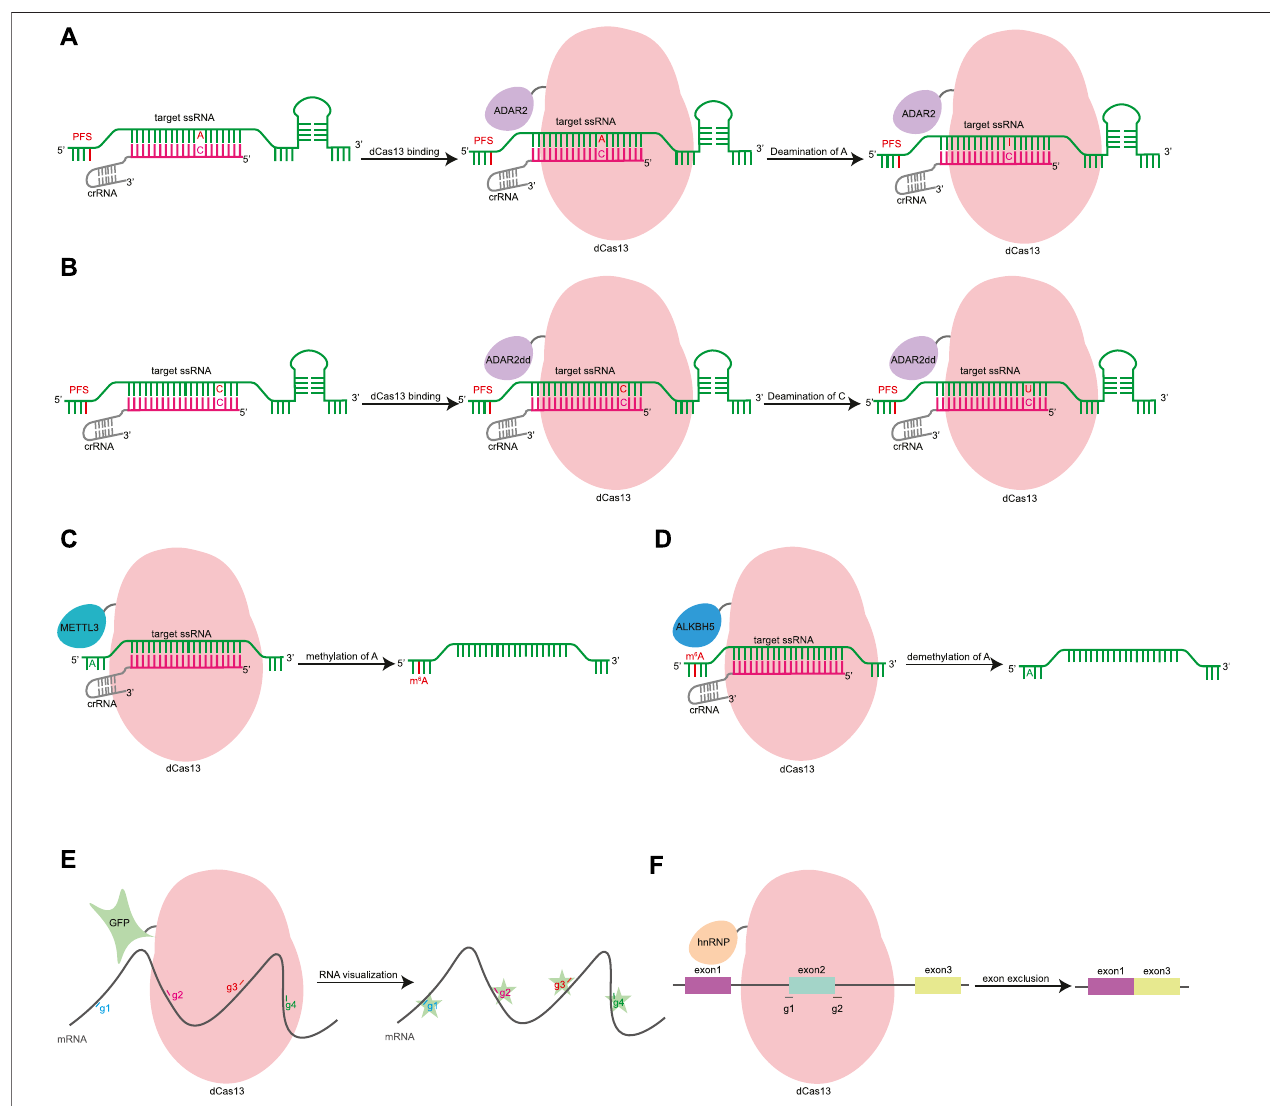
FIGURE 3 | Gene editing based on RNA-guided RNA-binding domain. (A) . dCas13 was fused with ADAR2 to develop REPAIR, which can realize the adenosine- to-inosine conversion of RNA. ADAR2, adenosine deaminase acting on RNA type 2. (B) . RESCUE uses a fusion of dCas13 and evolved ADAR2dd to catalyze C-to-U conversion of RNA. ADAR2dd, evolve the adenine deaminase domain of ADAR2. (C) . dCas13 can be fused with truncated METTL3 methyltransferase to induce site- speci fi cm6Achanges.METTL3,methyltransferase-like3. (D) .ThedCas13-ALKBH5fusionproteinachievesdemethylationofRNAatspeci fi csites.ALKBH5,m6A demethylase AlkB homolog 5. (E) . dCas13 can be fused with GFP for mRNA imaging. g1~4, gRNA 1 – 4. (F) . dCas13 can fuse with hnRNP, a negative regulator of splicing, to achieve targeted exon skipping. g1~2, gRNA 1 – 2. hnRNP, heterogeneous nuclear ribonucleoprotein.